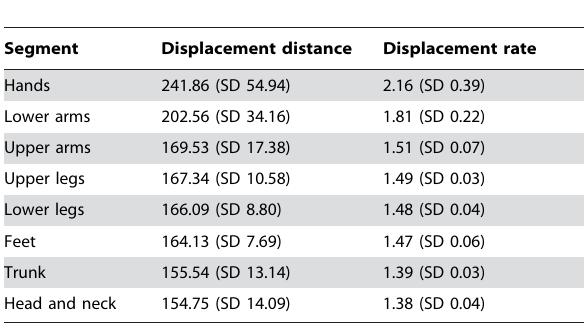
Table 3. Mean segment displacement distances and rates per